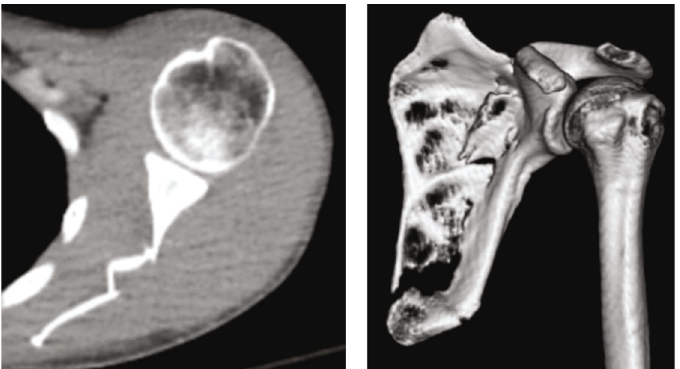
Figure 3: Standard CT and CT reconstruction image demonstrating more extensive left scapular body